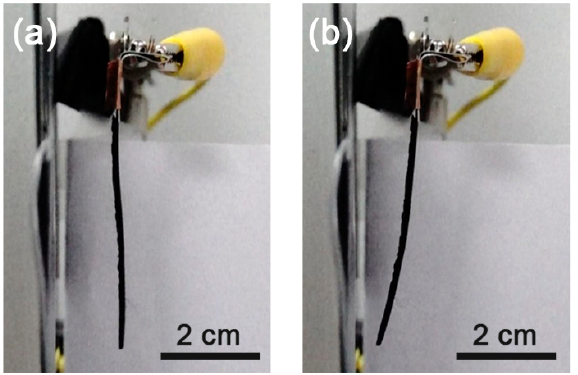
Figure 3. Motion of a Fe 3 O 4 -silicone composite actuator with an iron oxide concentration of 10% (240 fps). ( a ) Off-state and ( b ) on-state.